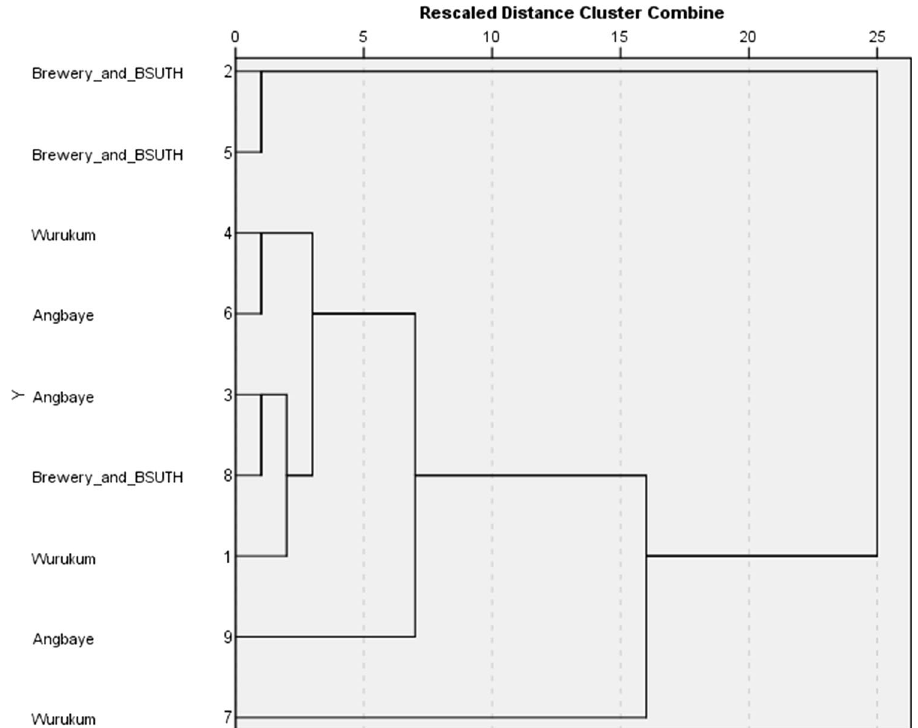
Fig. 6 Dendrogram of hierarchi- cal cluster analysis for all the stations in dry